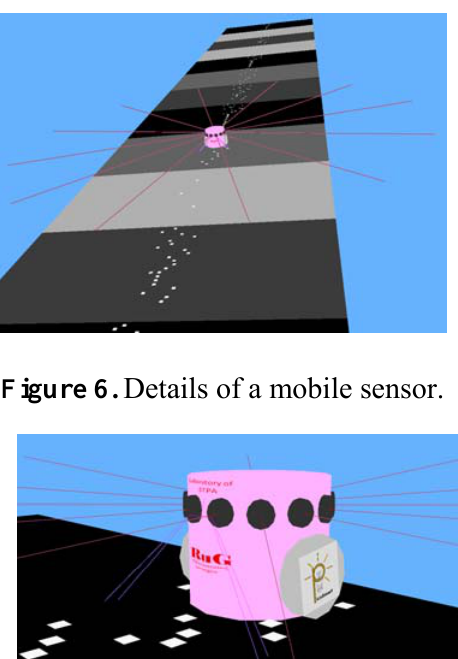
Figure 5. A snapshot of a moving mobile sensor.